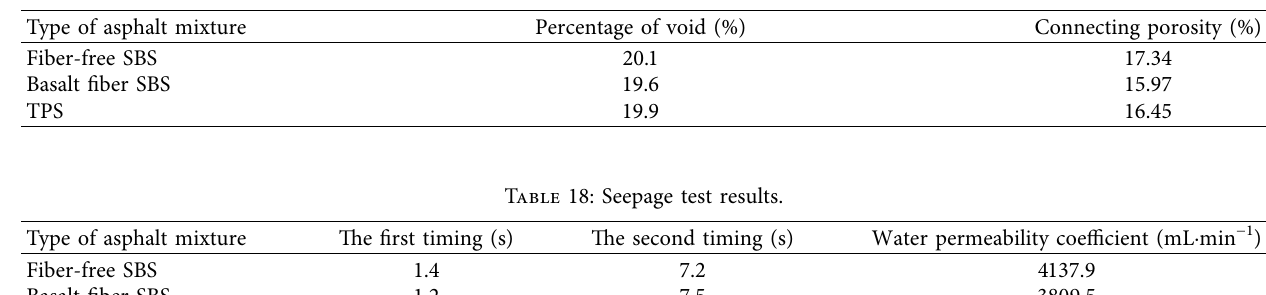
Table 17: Connected void fraction test results.